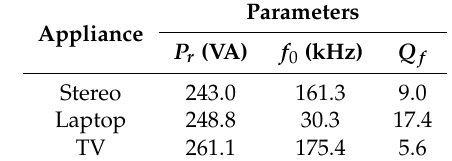
Table 6. Parameters for Three Appliances.